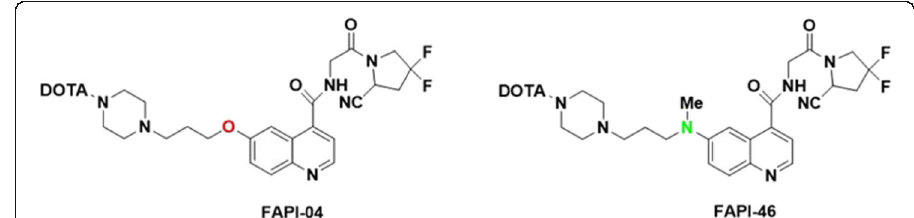
Fig. 1 Molecular Structures of FAPI-04 and